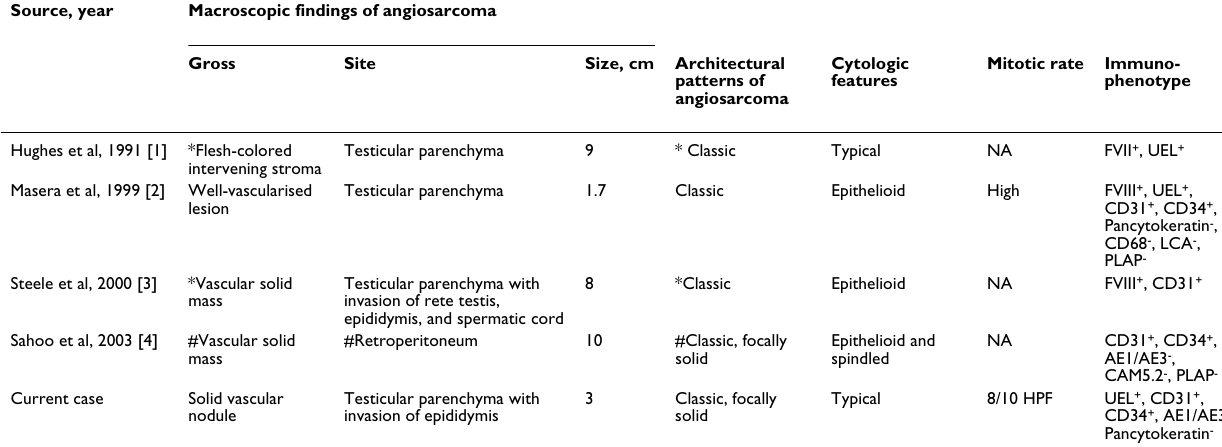
Table 2: Pathologic characteristics of primary testicular angiosarcoma Source, year